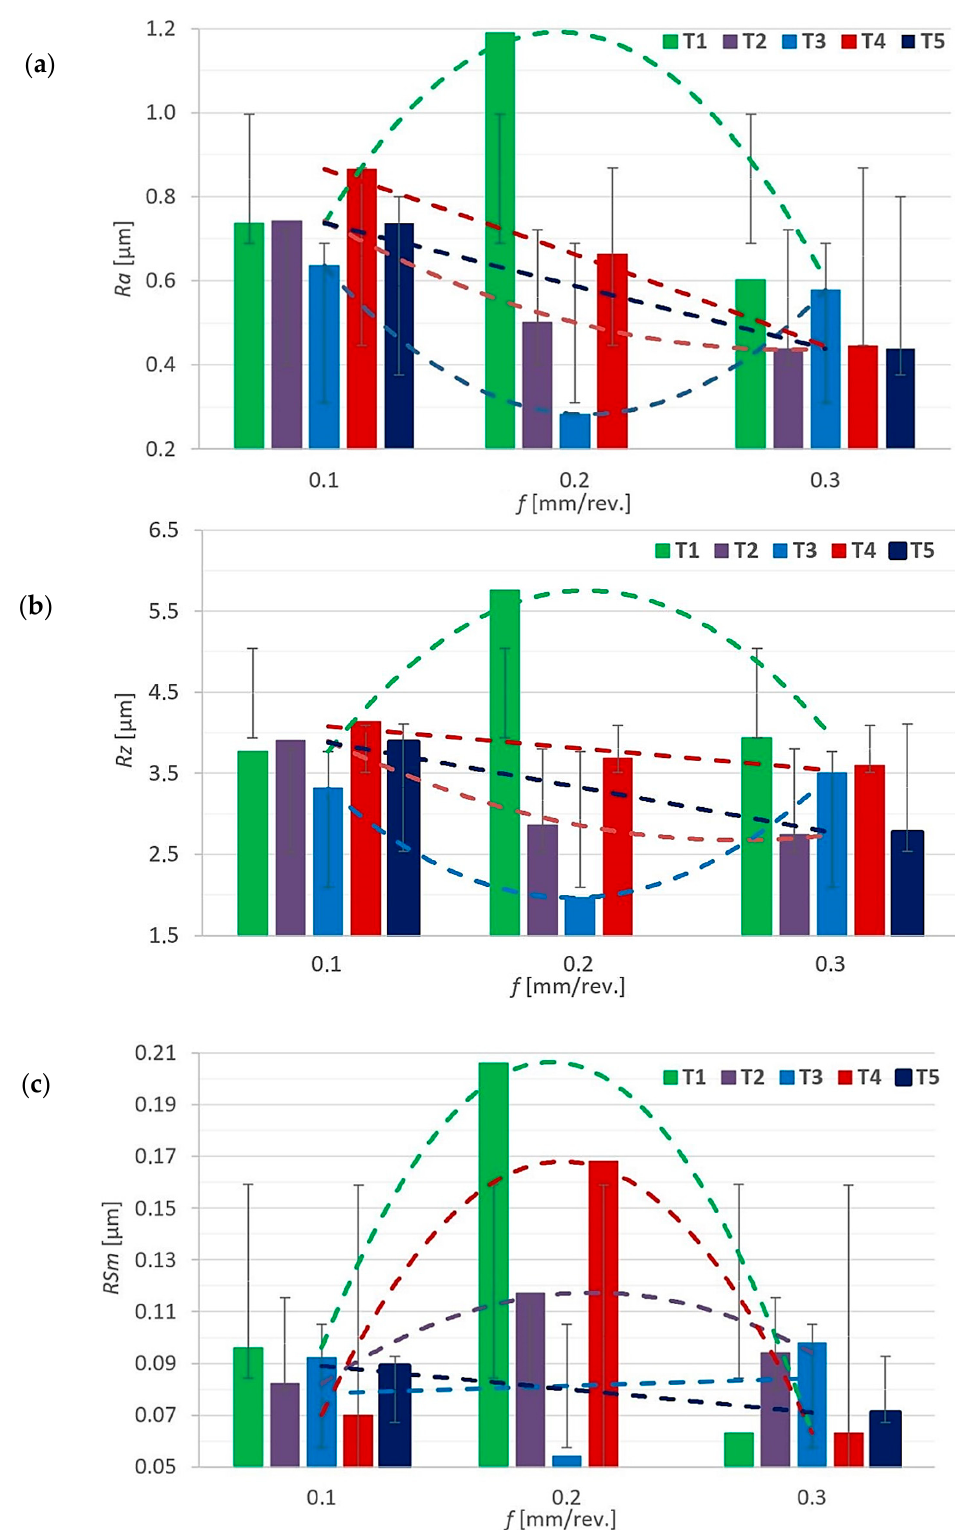
Figure 3. Values of selected parameters of surface roughness depending on the value of f feed and the type of cutting edge where: T1–T5—tool number; ( a )— R a (µm); ( b )— R z (µm); ( c )— RS m (µm). For feeds f 1 = 0.1 mm/rev. and f 3 = 0.3 mm/rev. the roughness parameter R a values for